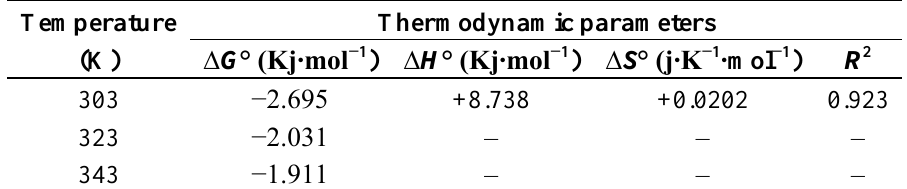
Table 8. Thermodynamic parameters of Cu(II) sorption onto activated